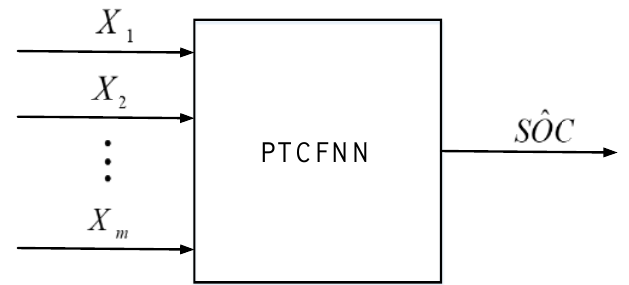
Figure 2. PTCFNN model.